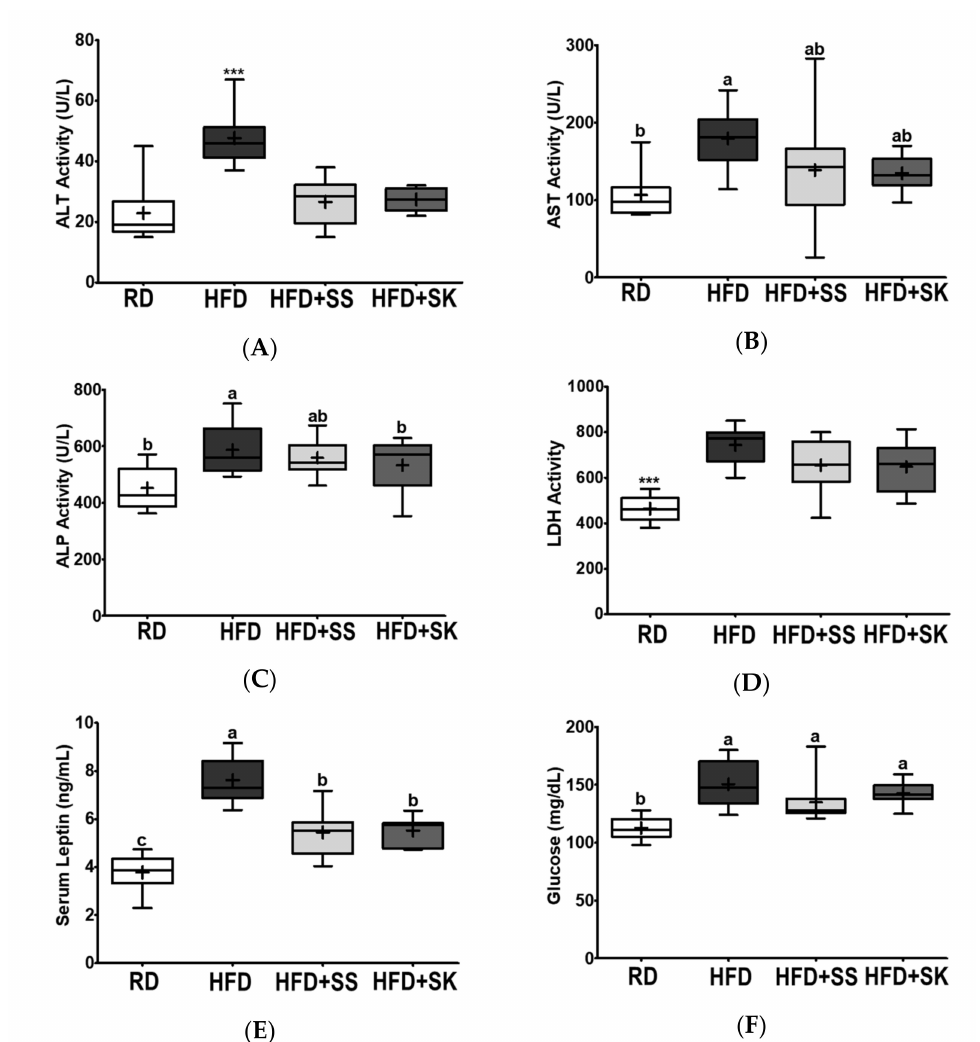
Figure 3. Effect of steamed soybean (SS) and soybean koji (SK) on biochemical markers of hepatic function, leptin, and glucose in HFD fed Sprague-Dawley rats. Experimental rats were fed a regular diet (RD) or a high-fat diet (HFD) with 3% SS (HFD+SS) or with 3% SK (HFD+SK) for 8 weeks. ( A ) Alanine aminotransferase (ALT), ( B ) aspartate aminotransferase (AST), ( C ) alkaline phosphatase (ALP), and ( D ) lactate dehydrogenase (LDH) activities and ( E ) leptin and ( F ) fasting glucose levels were analyzed enzymatically or biochemically. RD, regular diet; HFD, high-fat diet; HFD+SS, high-fat diet + 3% steamed soybean; HFD+SK, high-fat diet + 3% steamed soybean. Values are displayed as a box-and-whisker plot with means (expressed as ‘+’), n = 8. Data were analyzed using one-way ANOVA followed by Tukey’s post-hoc comparison. Means labeled without a common letter differ significantly, p < 0.05. *** p <